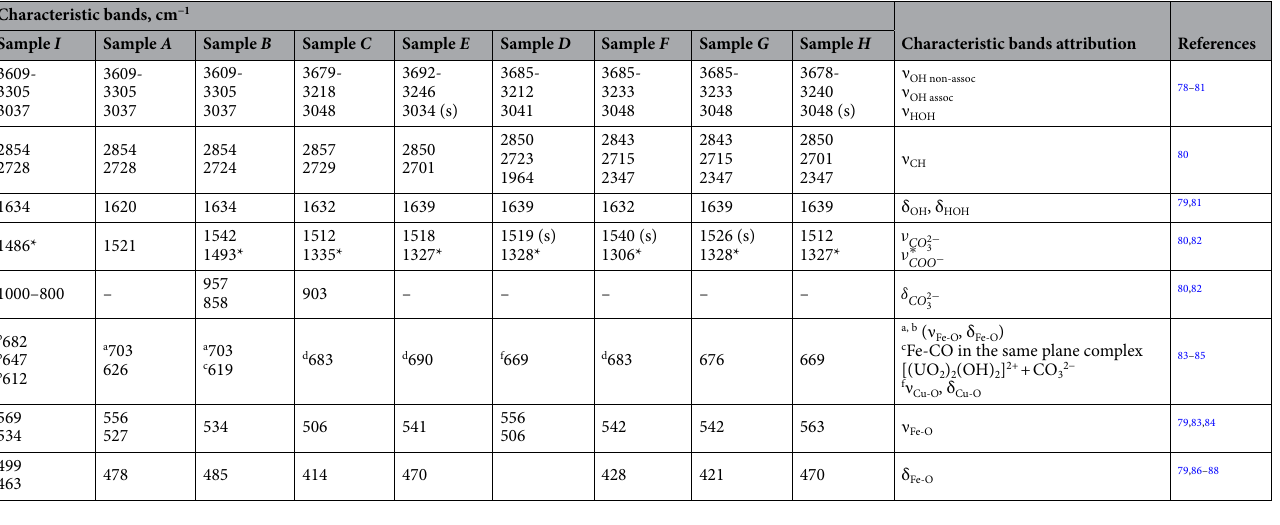
Table 1. Characteristic bands of sublates obtained after the separation by sorption/precipitate flotation of U(VI) from Cr (VI), Cu(II), and Mo(VI). Where : Sample I = Fe 2 O 3 ·nH 2 O symbolized as Fe (III); Sample A = Fe(III) + U(VI); Sample B = Fe(III) + U(VI) + Cr(VI); Sample C = Fe(III) + U(VI) + Cu(II); Sample E = Fe(III) + U(VI) + Mo(VI); Sample D = Fe(III) + U(VI) + Cr(VI) + Cu(II); Sample F = Fe(III) + U(VI) + Cr(VI) + Mo(VI); Sample G = Fe(III) + U(VI) + Cu(II) + Mo(VI); Sample H = Fe - (III) + U(VI) + Cr(VI) + Cu(II) +